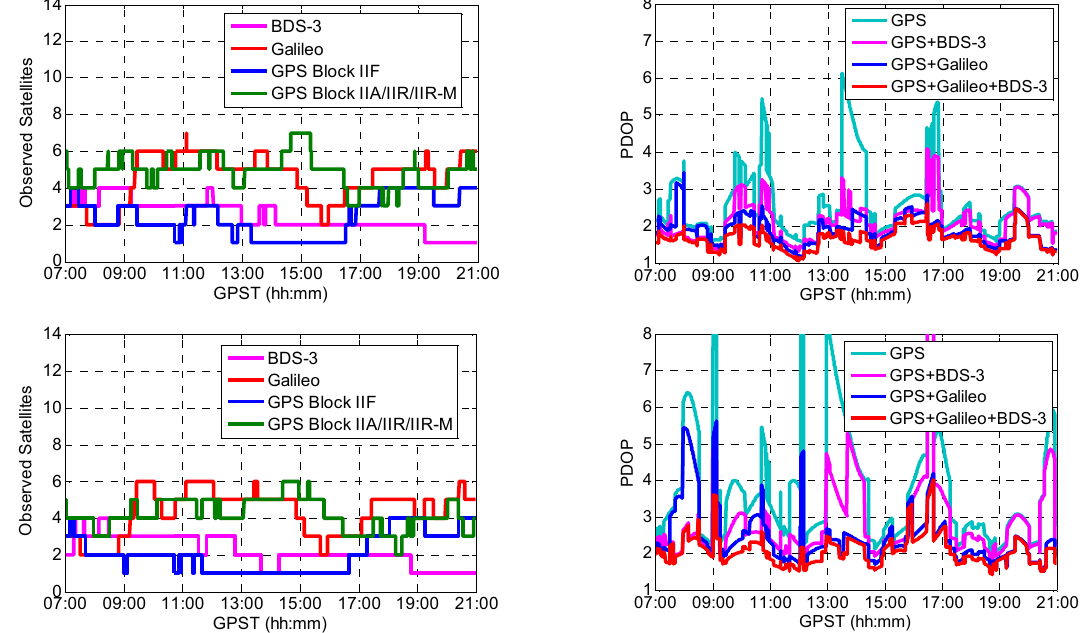
Figure 9. Number of satellites tracked and the corresponding PDOP series above 10 o ( top panels ) and 20 o ( bottom panels ) elevation cut-off angles.